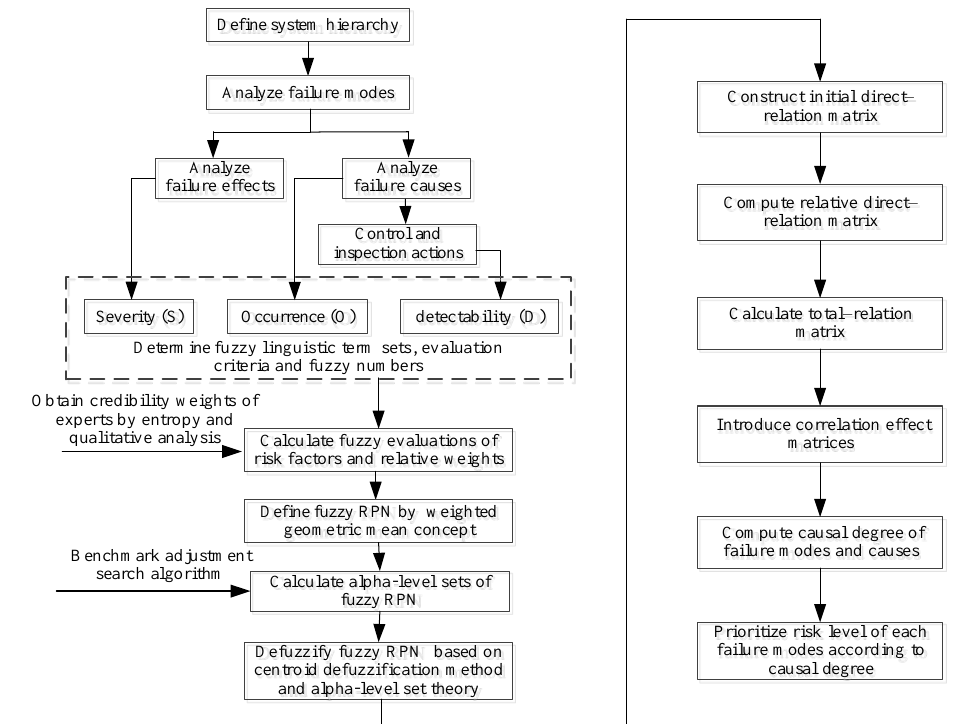
Figure 3. Flowchart of the proposed improved assessment method. RPN, risk priority number.